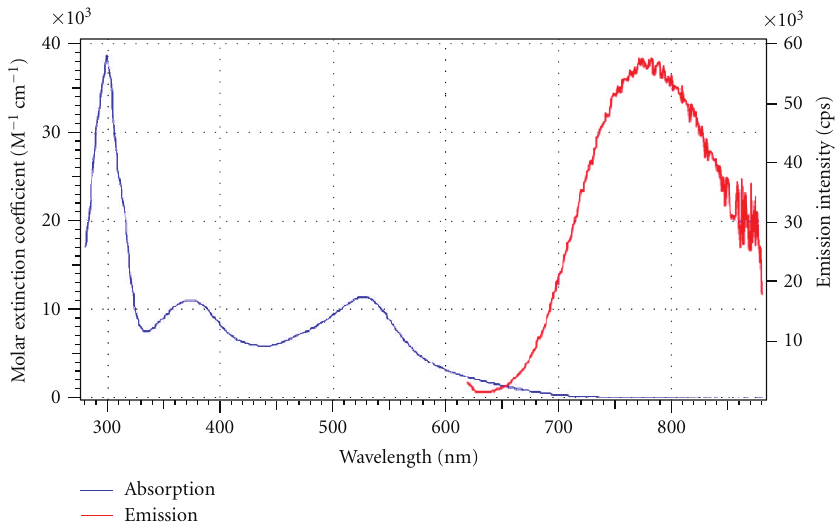
Figure 11: Electrical absorption and emission spectra of the K68 sensitizer in DMF solution (taken from [27]).